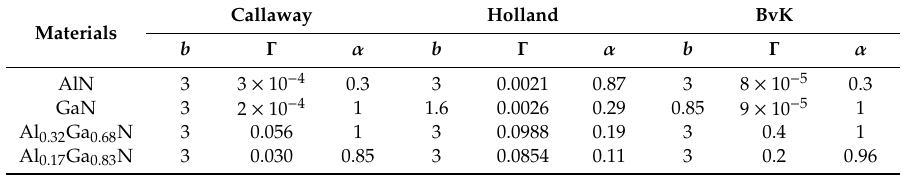
Table 2. Fitting parameters of several phonon scattering mechanisms used in the three models. Materials